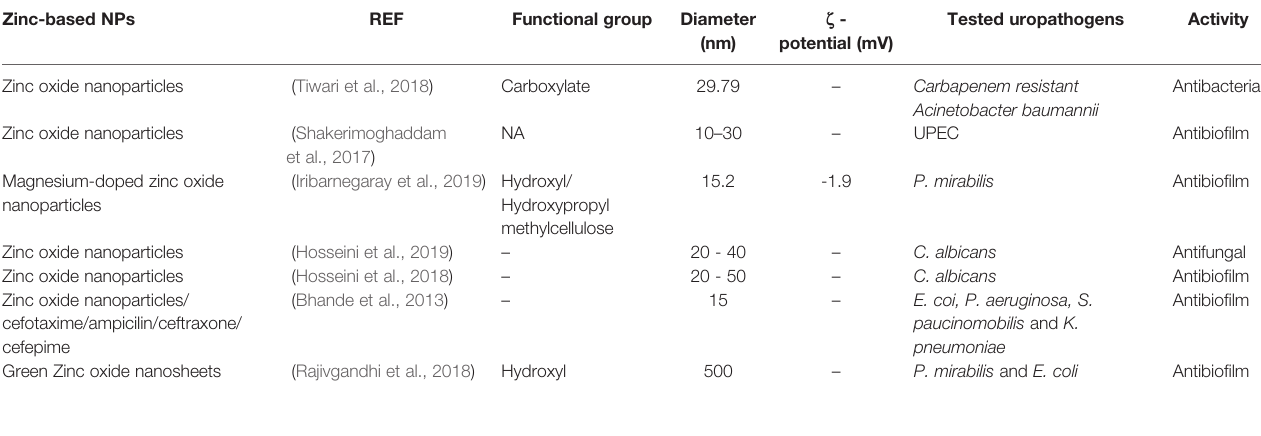
TABLE 7 | Physicochemical characteristics of zinc-based NPs.